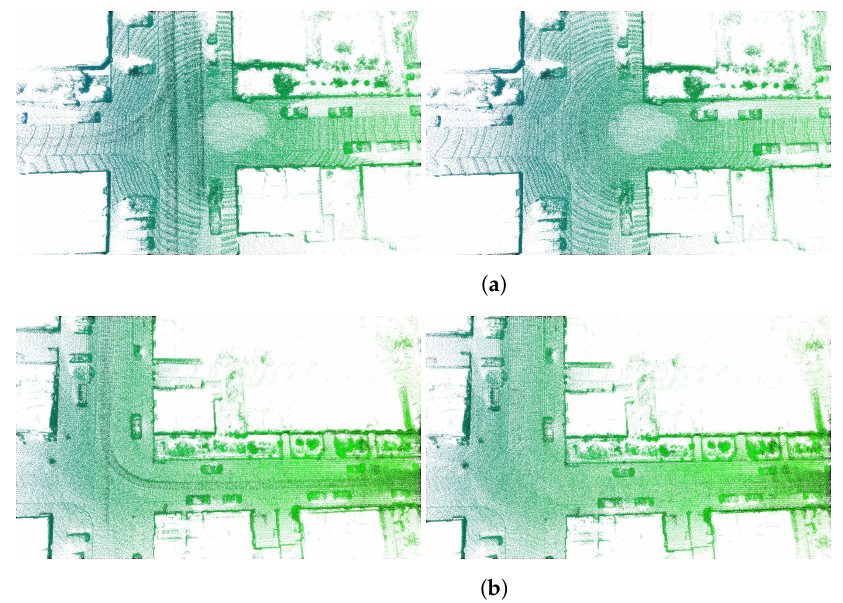
Figure 10. DOR examples for a single frame of lazer scan. ( a ) Seq.07. Vehicles crossing the intersection when the data collection vehicle stops and waits for the traffic light ( left ); The cyclist traveling in the opposite direction when the data collection vehicle is driving along the road ( right ). ( b ) Seq.10. Followers behind the data collection vehicle as it travels down the highway at high speed ( top ); Vehicles driving in the opposite direction and in front of the data collection vehicle when it slows down ( bottom ). (facade, ground, edge and dynamics for points true positive, false positive and true negative for dynamic segmentation boxes.)